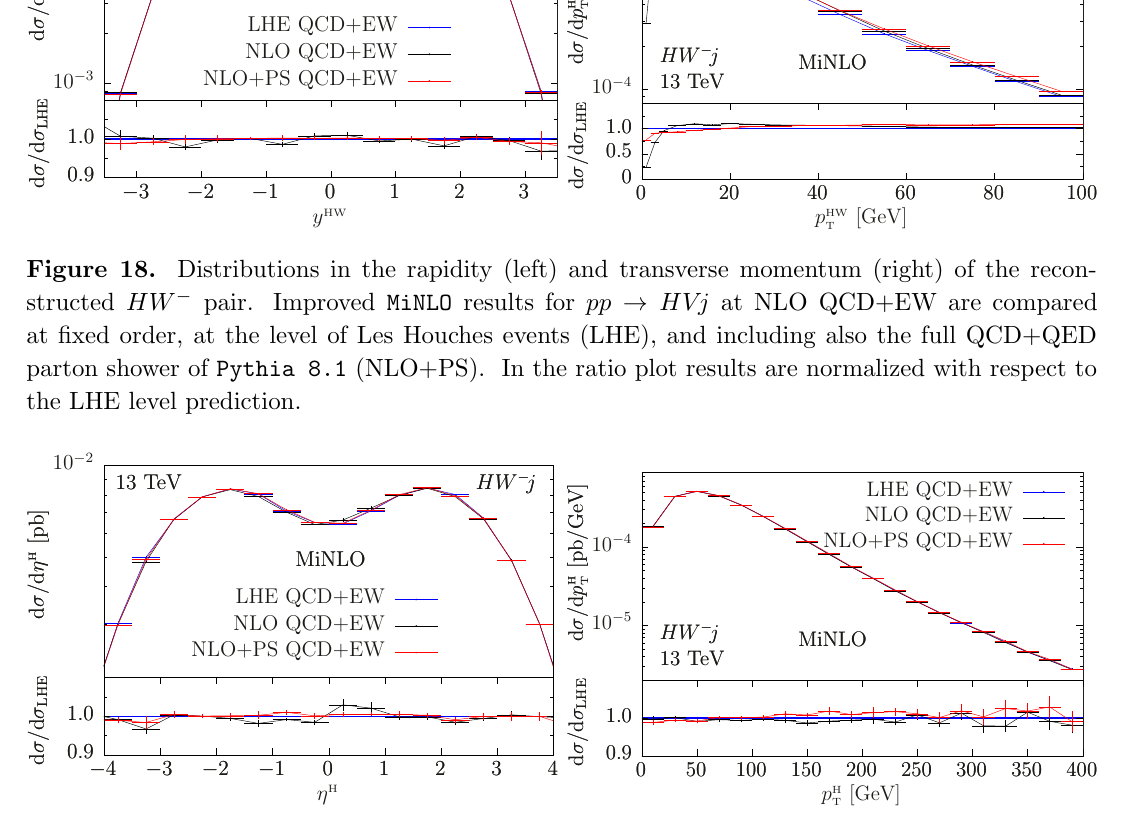
Figure 19. Distributions in the pseudorapidity (left) and transverse momentum (right) of the Higgs boson in the MiNLO improved pp HW (cid:0) j simulation. Same curves and labels as in (cid:12)gure 18. ! predictions for the p distribution are (cid:12)nite at small p , since soft and collinear divergences T T are suppressed by the MiNLO Sudakov form factors. Moreover, the NLO accuracy in the spectrum of the HW (cid:0) system leads to an improved agreement between (cid:12)xed-order and NLO+PS